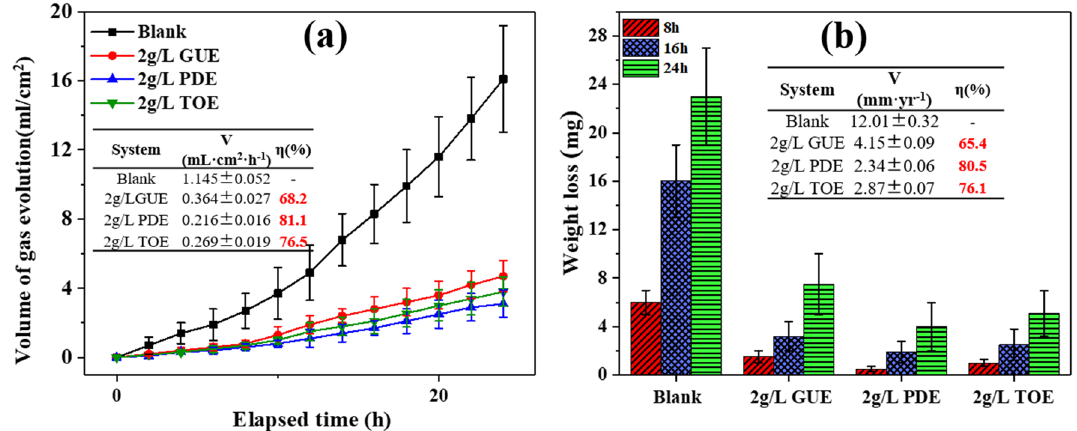
Figure 3. Immersion tests of AZ91alloys in 3.5 wt% NaCl solution without and with 2.0 g/L GUE, PDE and TOE for 24 h. ( a ) Hydrogen evolution volume as function of elapsed time; ( b ) Wight-loss at different time